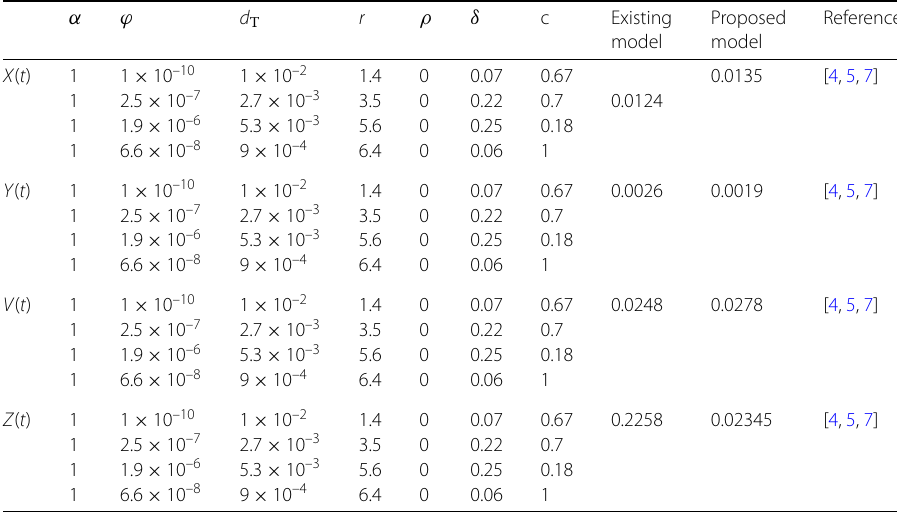
Table 5 Comparison study of existing work and proposed work